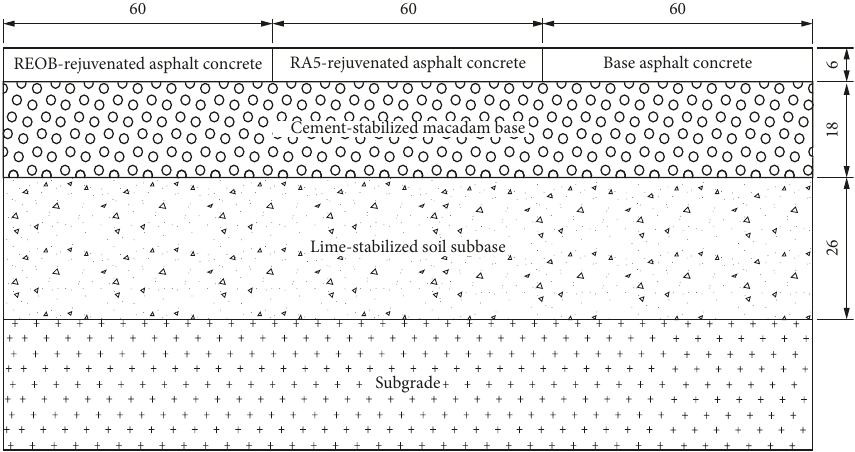
Figure 7: Structural sketch of full-scale indoor test road